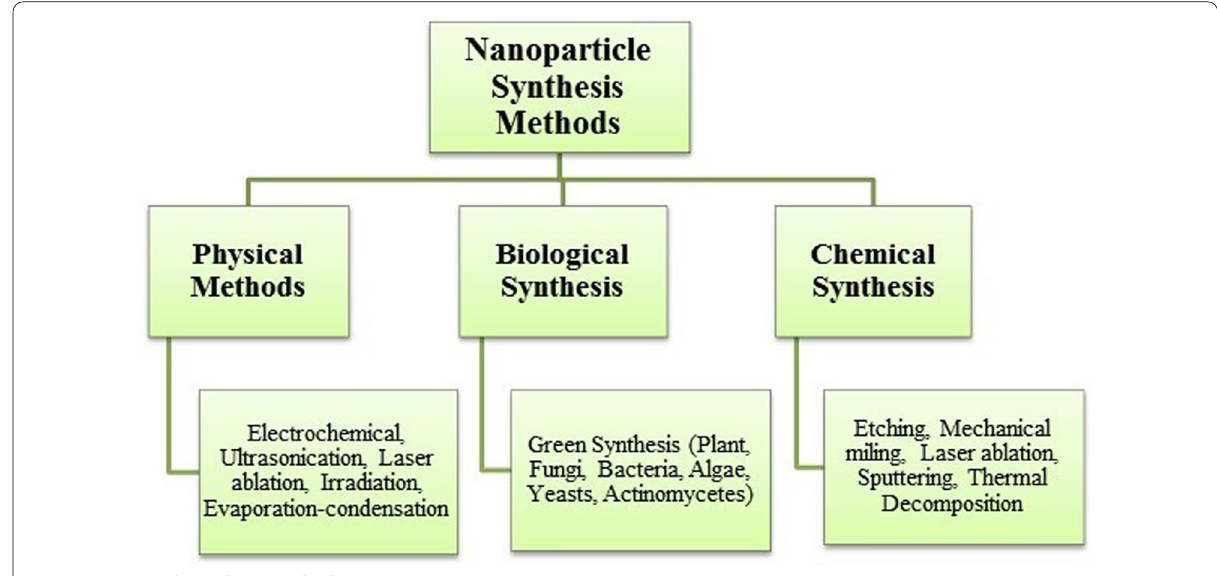
Fig. 1 Nanoparticle synthesis